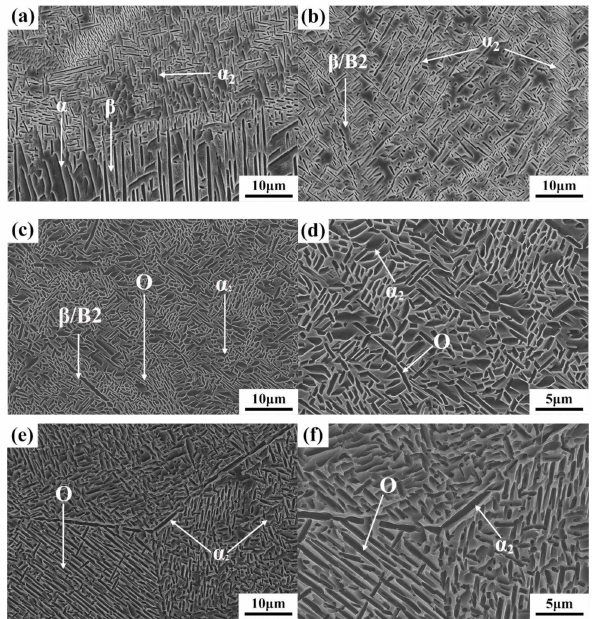
Figure 10. ( a ) microstructure evolution of Region 1; ( b ) microstructure evolution of Region 2; ( c ) microstructure evolution of Region 3; ( d ) highly magnified microstructure evolution of Region 3; ( e ) microstructure evolution of Region 4; and ( f ) highly magnified microstructure evolution of Region